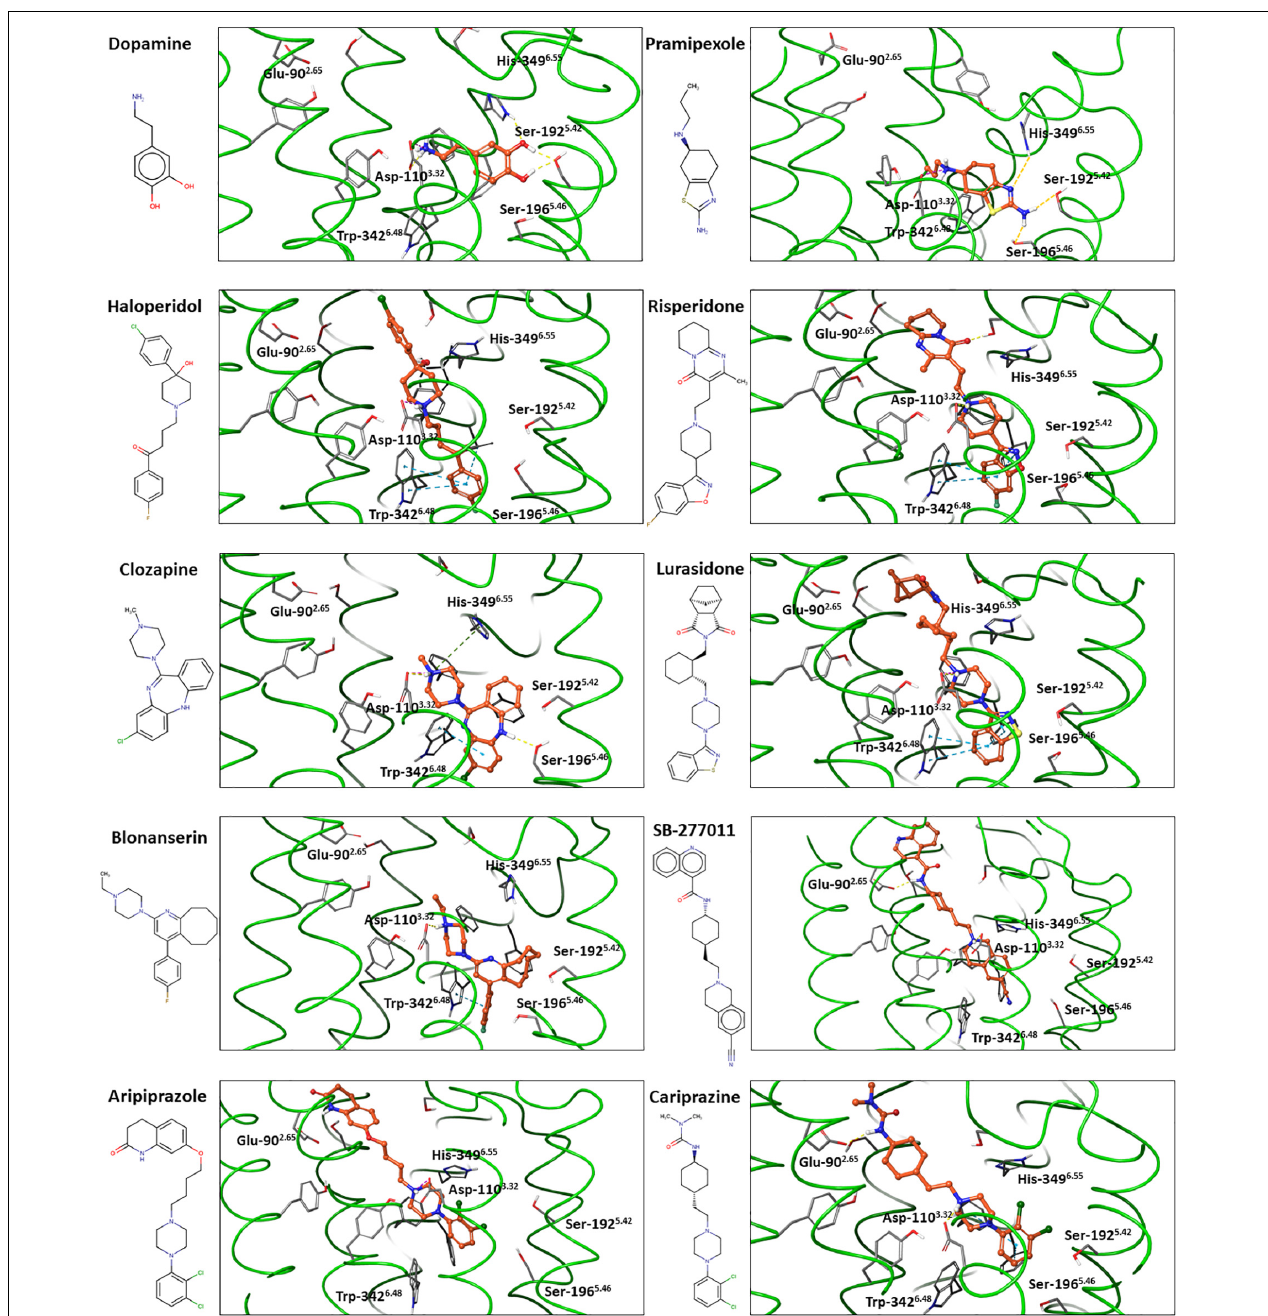
FIGURE 4 | Dopamine, pramipexole and selected antipsychotics docked into experimental D 3 R structures*.